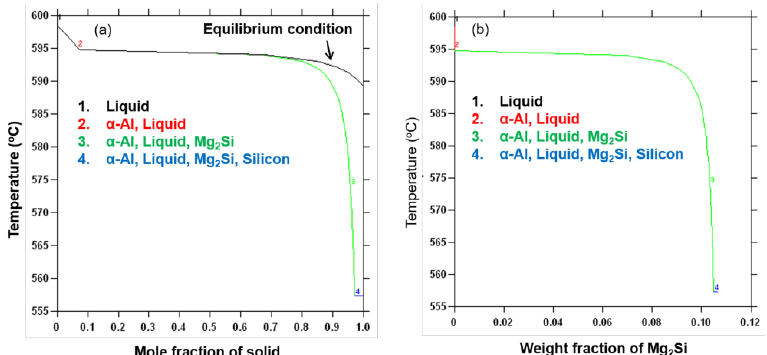
Figure 2. ( a ) Mole fractions of all solids formed during the solidification of a near-eutectic Al-13.1 wt.% Mg 2 Si alloy and ( b ) the weight fraction of the Mg 2 Si phase in an Al-13.1 wt.% Mg 2 Si alloy without the addition of chemical elements. The labeled number indicates the solidification range of the solid phases. The simulation is based on a Scheil model. The black curve in ( a ) was predicted under equilibrium